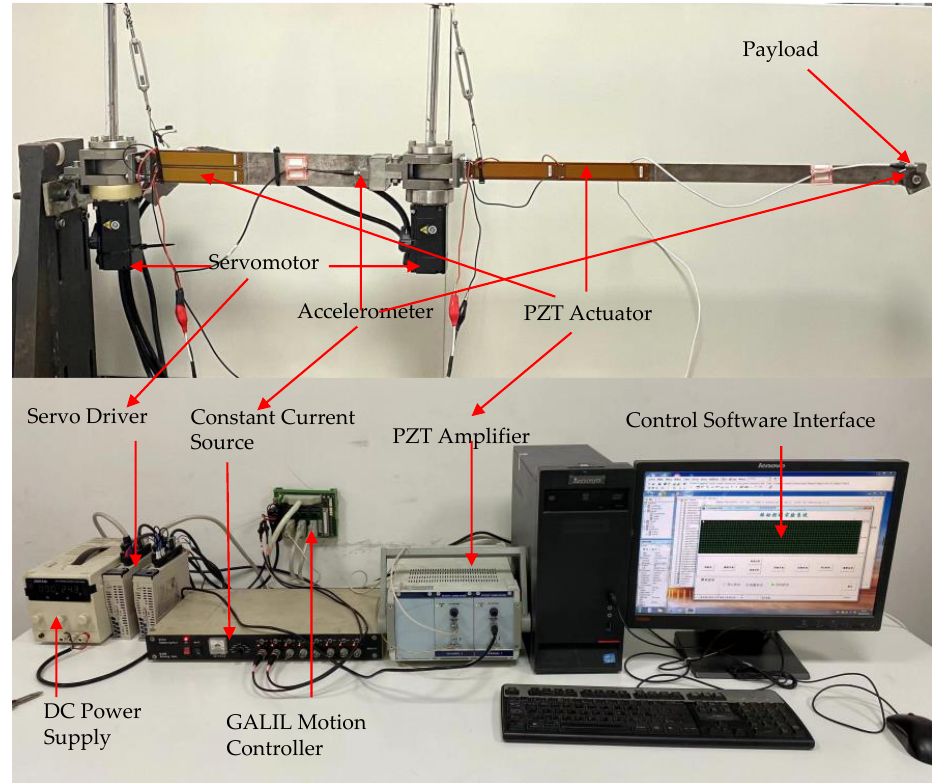
Figure 18. Scheme of the two-link flexible manipulator experimental setup. The experimental results of the setpoint motion control are shown in Figures 19 and 20. indicates that both PD and AFC can suppress residual vibration, although AFC had a better performance than the PD controller in suppressing the residual vibrations. The root mean square (RMS) and the amplitude of the whole course corresponding responses are listed was attenuated by 78.3%, while one with the PD controller attenuated by only 44.9%. This demonstrate that serious buffet occurs under PD control, and the position error of PD is larger than for CTM. The position error of joint 2 is larger than for joint 1 under PD control during the motion, as shown in Figure 19c,d. The experimental performance of CTM was worse than the simulated performance. The position error was more significant during the first 3 s. CTM cannot perform high-precision trajectory tracking in the experiment. A possible reason is that the mathematical model does not consider the influence of nonlinear factors, such as friction and clearance, in the actual